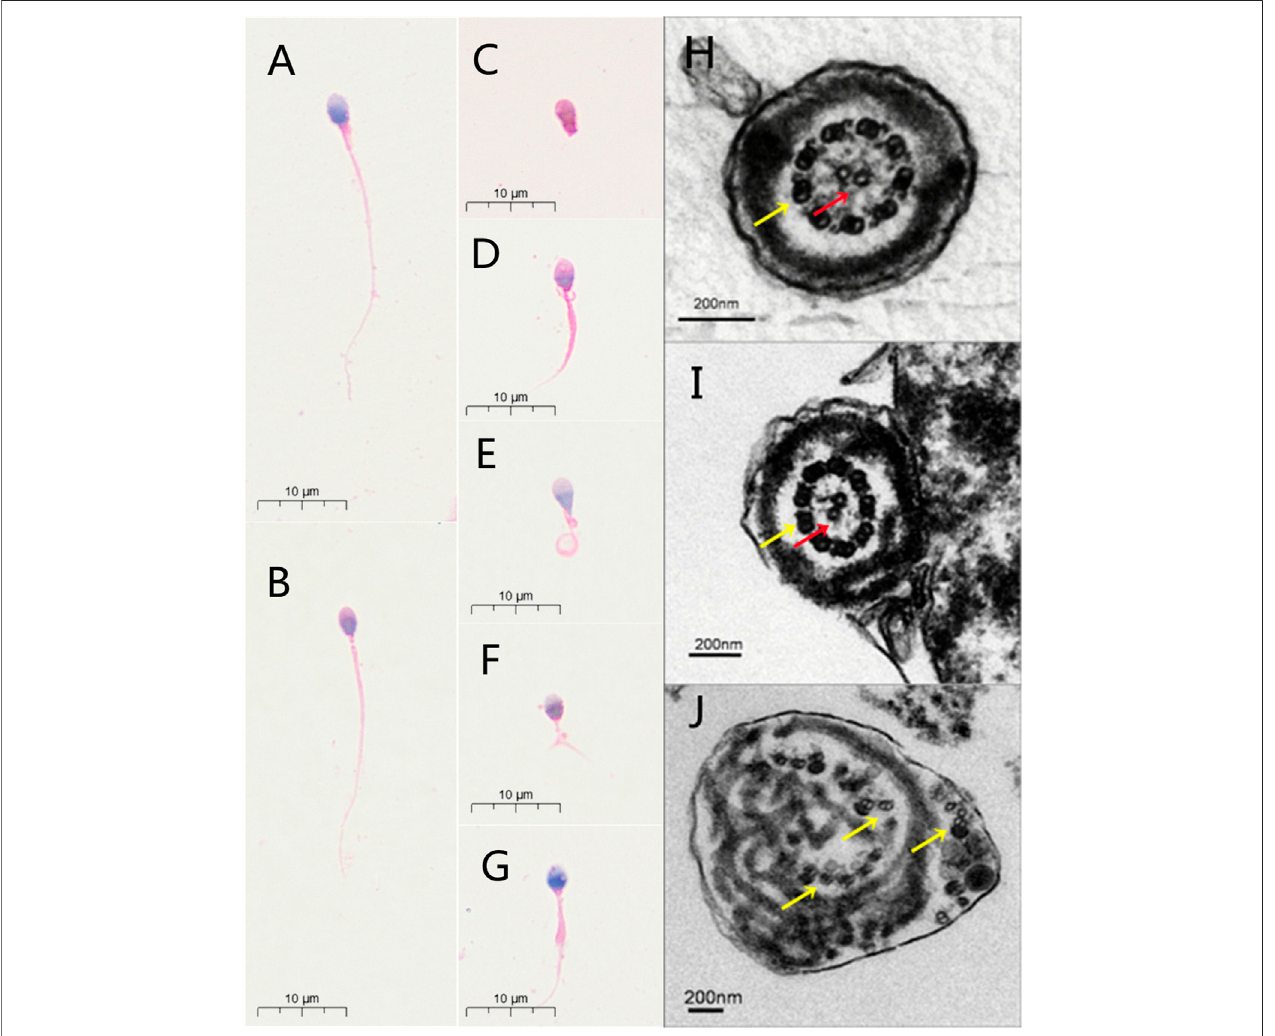
FIGURE 1 | Sperm morphology analyses for men with CFAP251 variant. Normal morphology of spermatozoa from a healthy control male as revealed by light microscopy (A) . The observed normal length of the sperm from a man harboring homozygous CFAP251 sp licing variant (B) . In addition, multiple malformations can be observed,includingabsent (C) ,short (D) ,coiled (E) ,bent (F) andirregularcaliber fl agella (G) .UnderTEM,thecrosssectionofthenormalspermandveryfewspermfrom men with CFAP251 variant show a typical “ 9+2 ” structure of microtubules and the regularly arranged outer dense fi brous sheath (H,I) . Most of the sperm from the men with CFAP251 variant show a severe disorder in the arrangement of the fl agellar ultrastructure (J) . Central pair of microtubules (red arrows); peripheral microtubule doublet (yellow arrows).